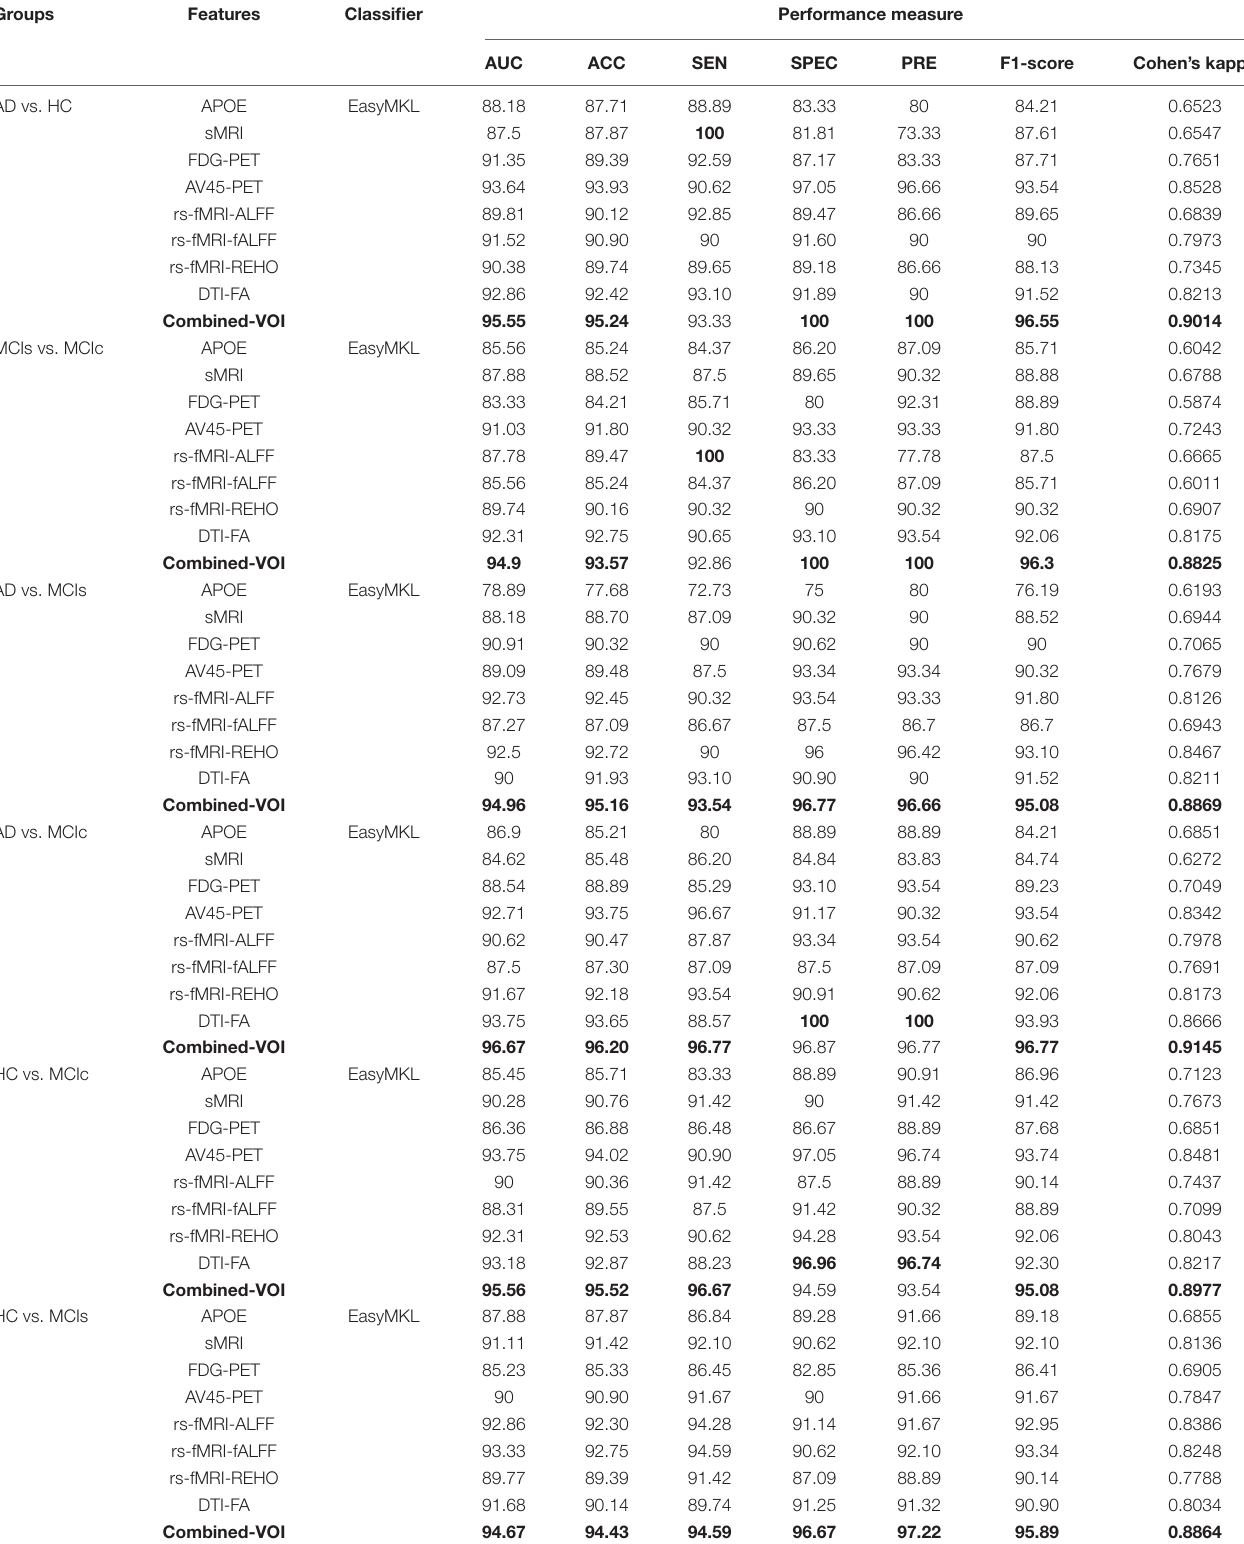
TABLE 3 | Classification results for AD vs. HC, MCIs vs. MCIc, AD vs. MCIs, AD vs. MCIc, HC vs. MCIc, and HC vs. MCIs groups using voxel-wise (VOI) features (EasyMKL).